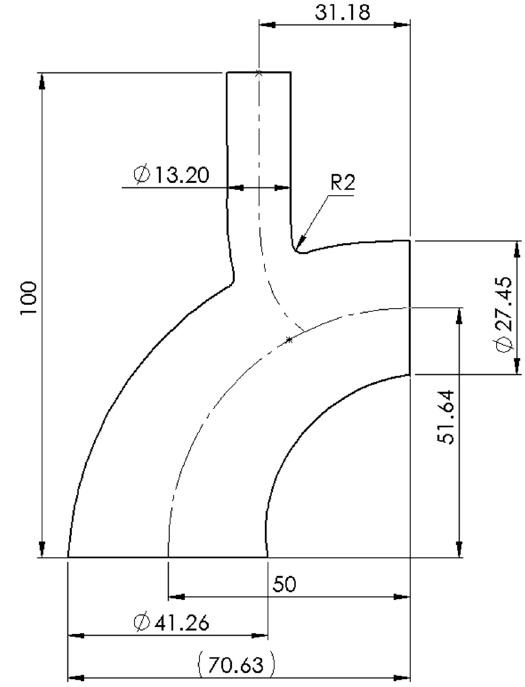
Figure 1. Schematic view of the phantom internal surface.